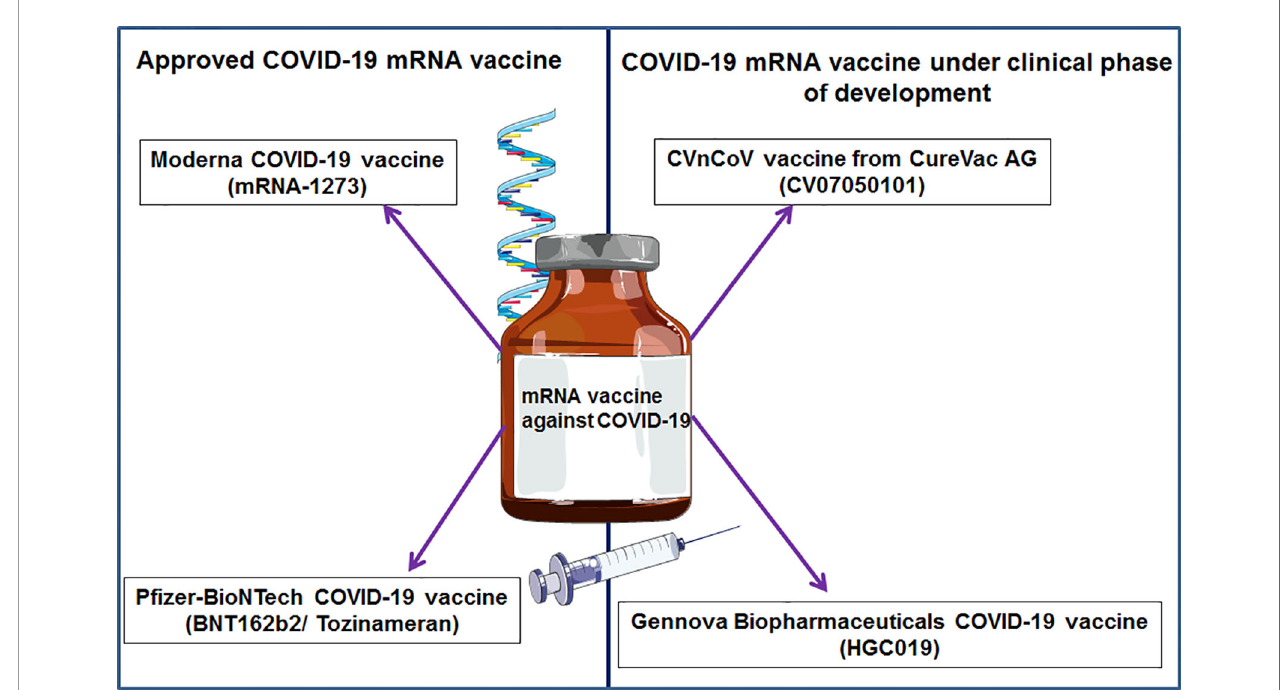
FIGURE 6 | Different signi fi cant COVID-19 mRNA